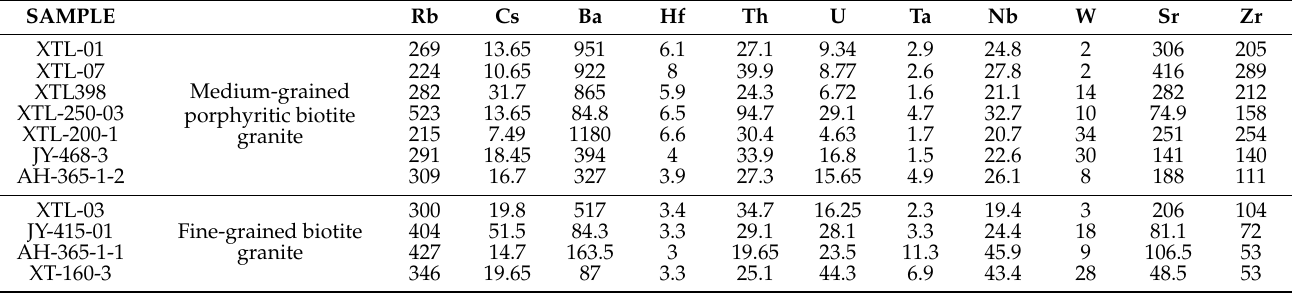
Table 2. Trace elements of granite in Xintianling ore field, Hunan